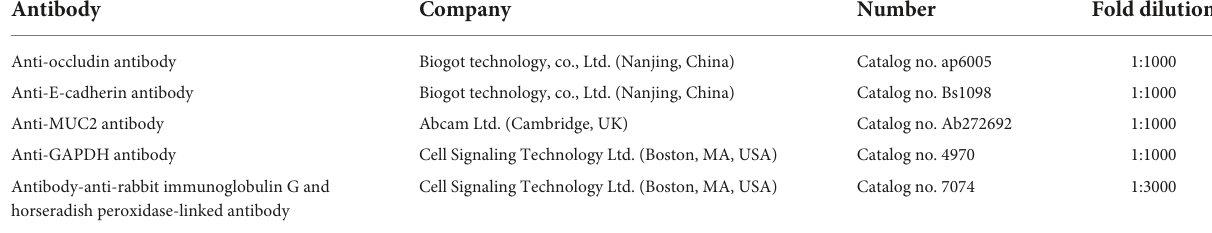
TABLE 2 The antibodies used in Western